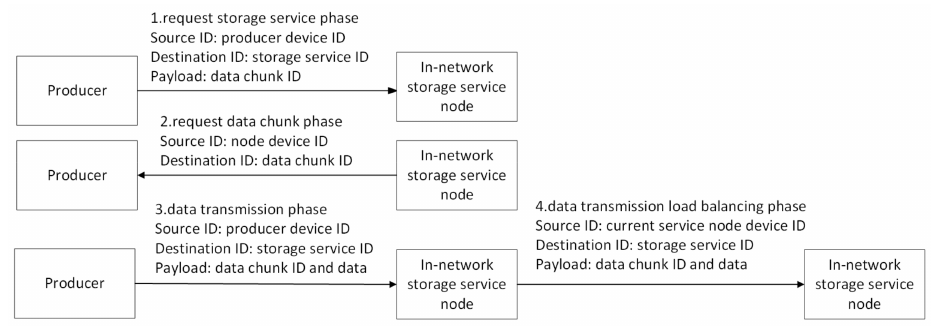
Figure 3. ID combination relationship in an in-network storage service